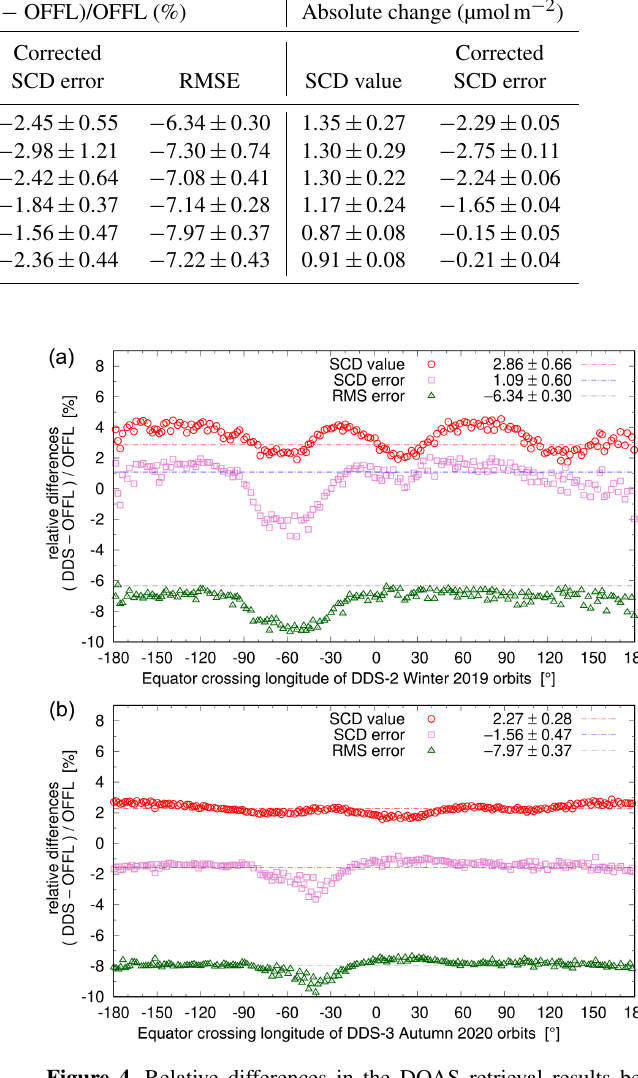
Figure 3. Along-track averages over the latitude ranges [0 to + 40 ◦ ] and [ − 40 ◦ to 0] of the SCD error (a) and the SCD in terms of the GCD value (b) of orbit 03707 of 1 July 2018 as a function of the across-track detector row number. The legend refers to the NO 2 pro- cessor settings for outlier removal listed in Table 2 and the version of the level-1b spectra used as input. See the text for further discus- sion and details.